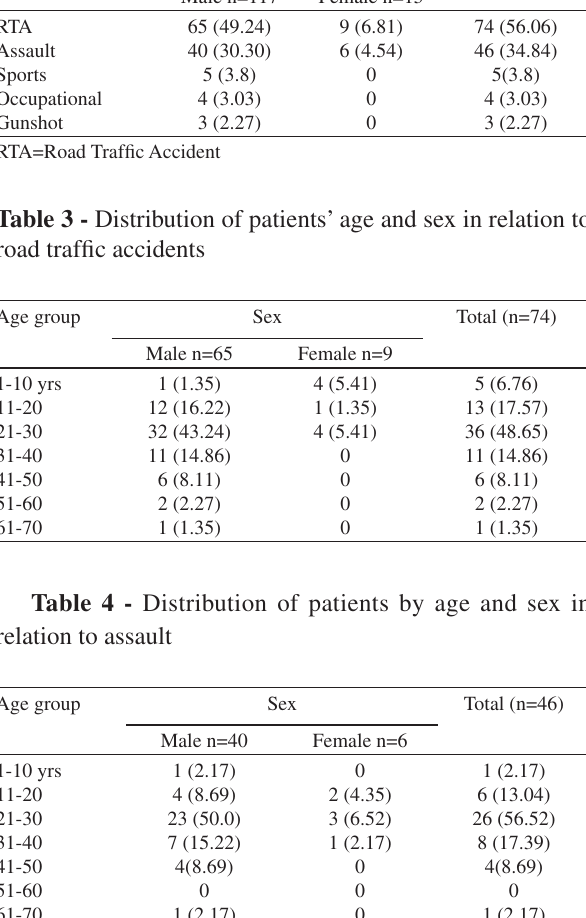
Table 2 - Distribution of patients according to cause of injury Cause of injury